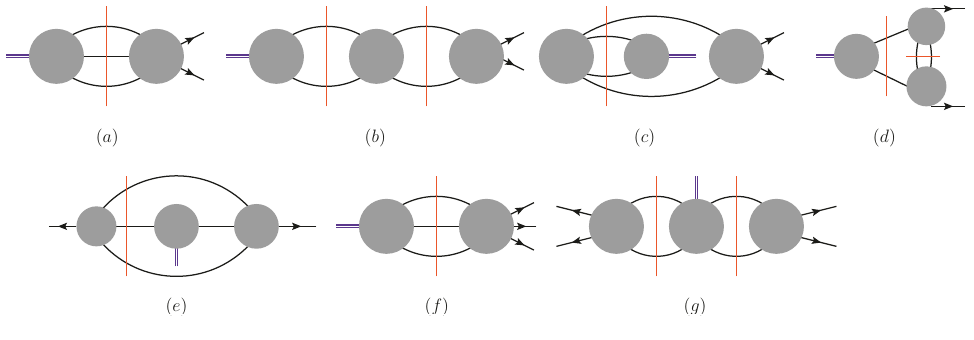
Figure 4 . The two-loop